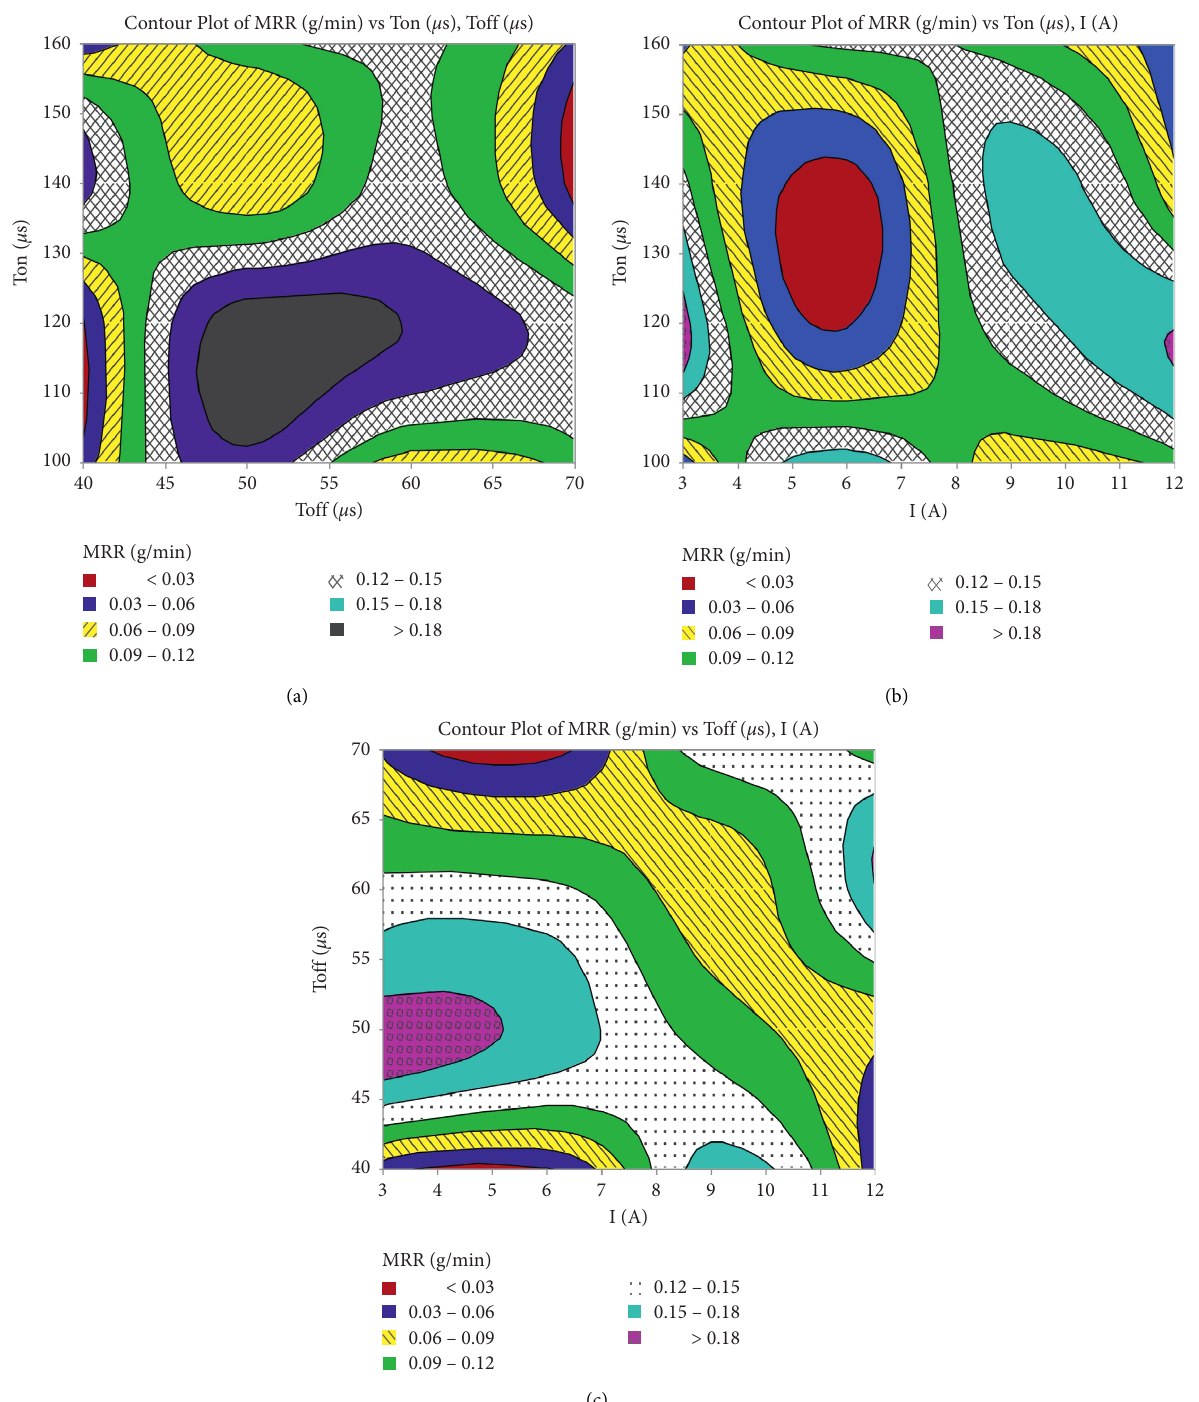
Figure 4: (a). Contour plot for MRR T OFF vs. T ON . (b) Contour plot for MRR I vs. T ON . (c) Contour plot for MRR I vs. T OFF